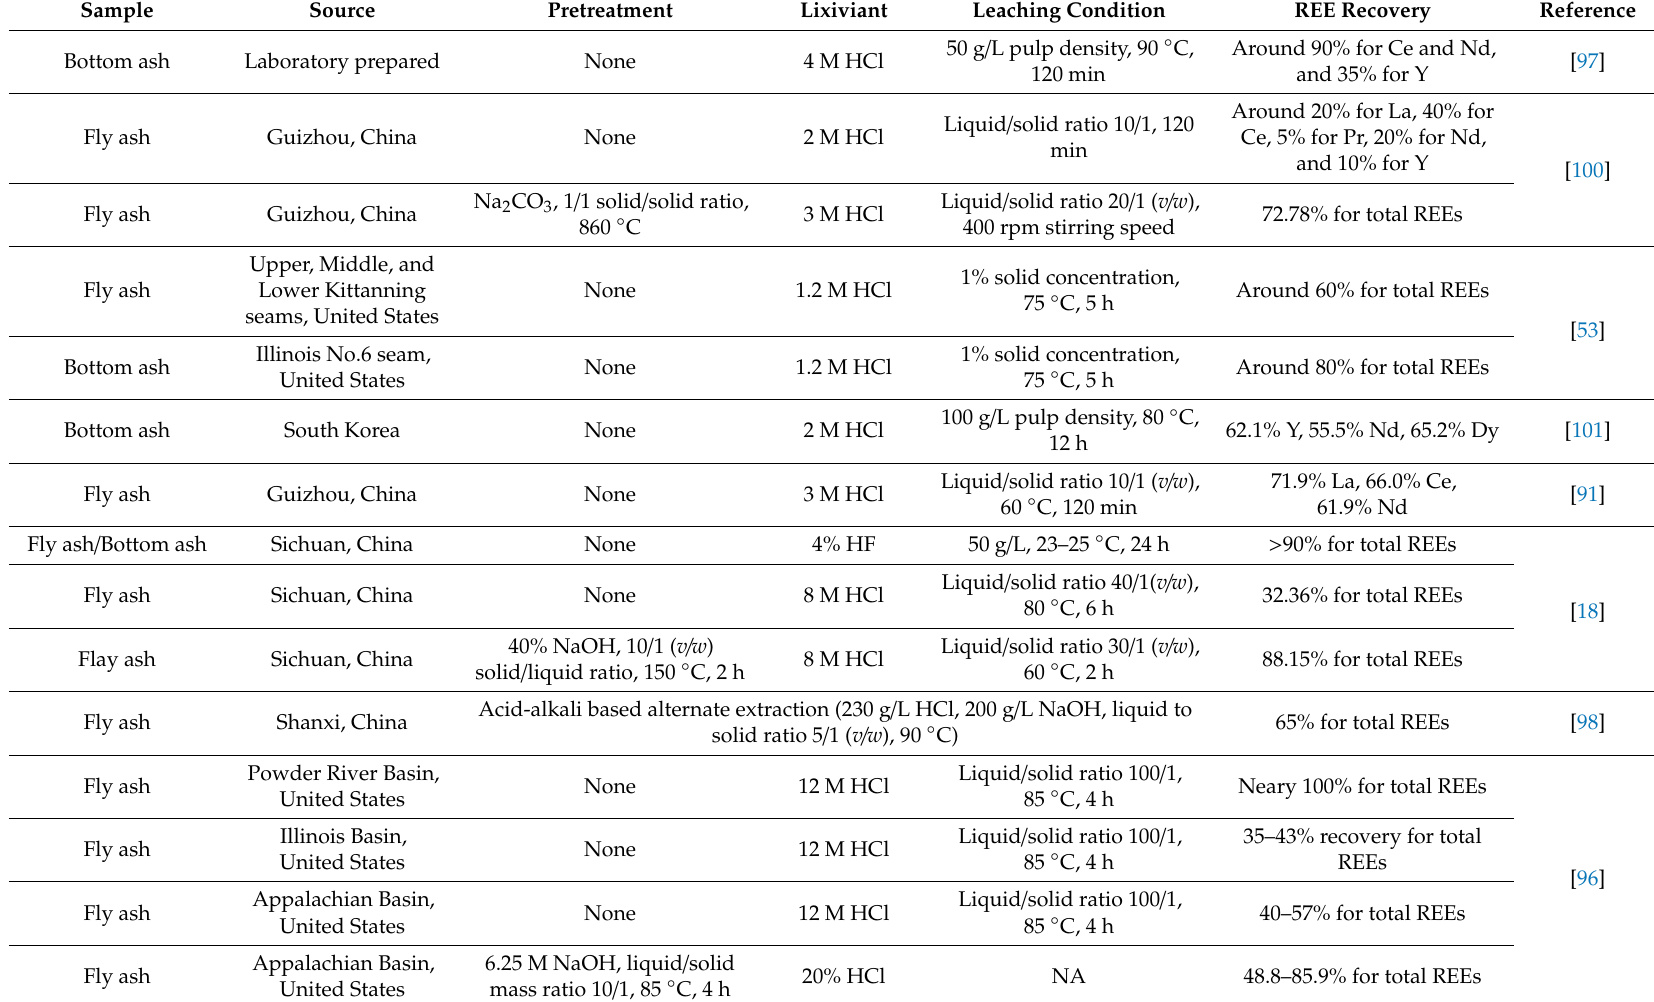
Table 4. Summary of REE extraction from coal combustion ash using chemical